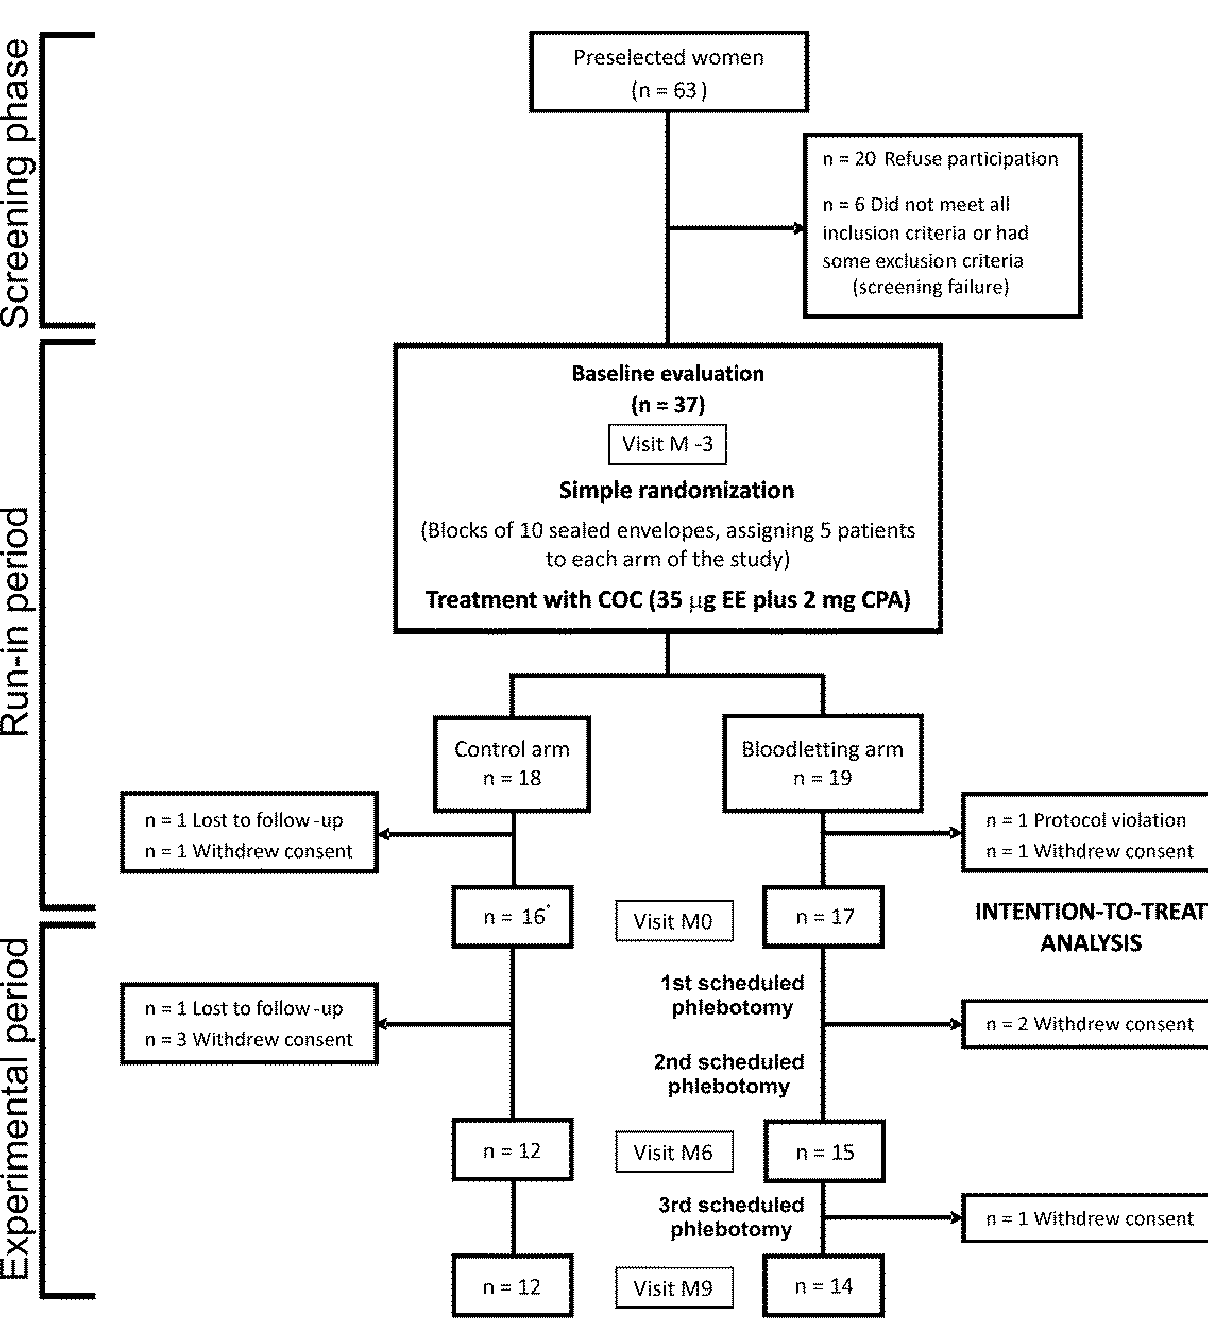
Figure 1. Flow chart of the study. The figure includes the numbers of participants randomly as- signed to the arms of the study, those receiving the intended intervention, and the losses and exclu- sions, together with their reasons, occurring after